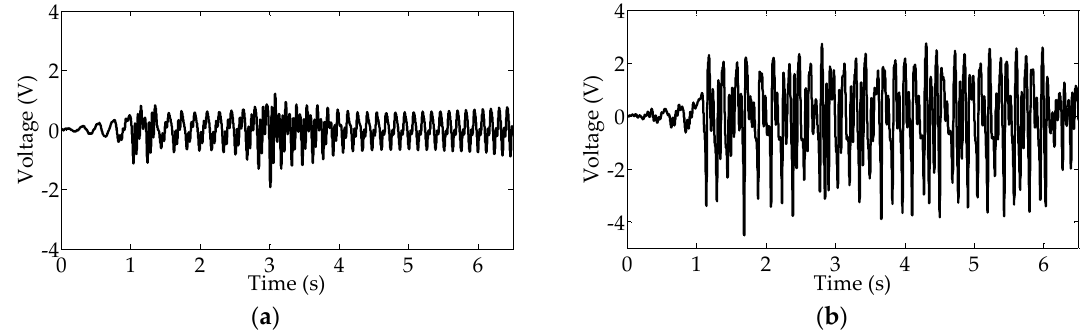
Figure 15. Produced voltages: ( a ) under up-sweep excitation; ( b ) under the combination of up-sweep excitation and on-road noise excitation.